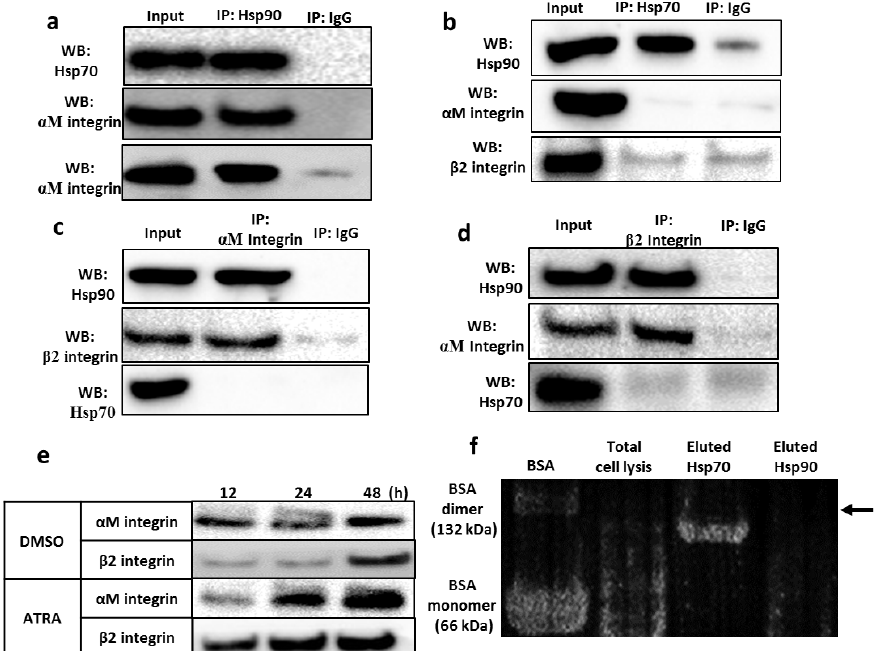
Figure 5. Hsp90 interacts with Hsp70 and integrin αMβ2 in the cell surface complex of THP -1 cells. ( a – d ) Coimmunoprecipitation (Co-IP) was performed from whole-cell lysate of ATRA-stimulated THP-1 cells with specific antibodies against Hsp90 ( a ), Hsp70 ( b ), αM integrin ( c ) or β2 integrin ( d ). The precipitates were immunoblotted with antibodies indicated on the left of panels. IgG represents a control antibody used for IPs. ( e ) Cell surface Hsp90- bound integrin αMβ2 was induced by ATRA treatment. THP-1 cells were treated with 1 µM ATRA for different time points. The cell surface protein was biotinylated, immunoprecipitated with anti-Hsp90 antibody and immunoblotted with anti- αM/ β2 integrin antibodies. ( f ) Calcium-binding capacity of Hsp70. The band illustrating Hsp70 (lane 3) or Hsp90 (lane 4) or the total cell lysis (lane 2) was eluted from the gel and run onto SDS-PAGE followed by membrane transfer. BSA was used as a positive control (lane 1). Membrane was then incubated with the developing solution for detecting calcium-binding protein.